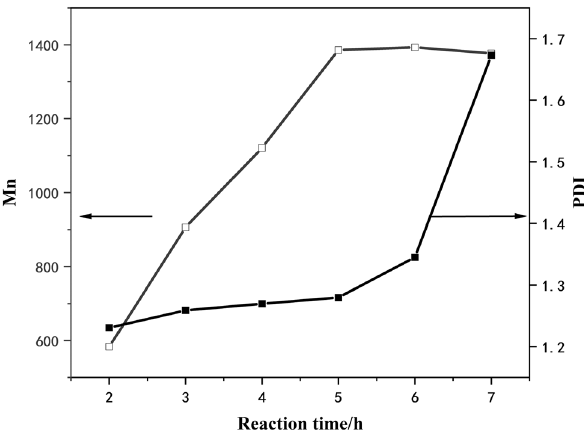
Figure 4: The e ff ect of reaction time on the M n and PDI of PCL diol ( the reaction time was 5 h ) .